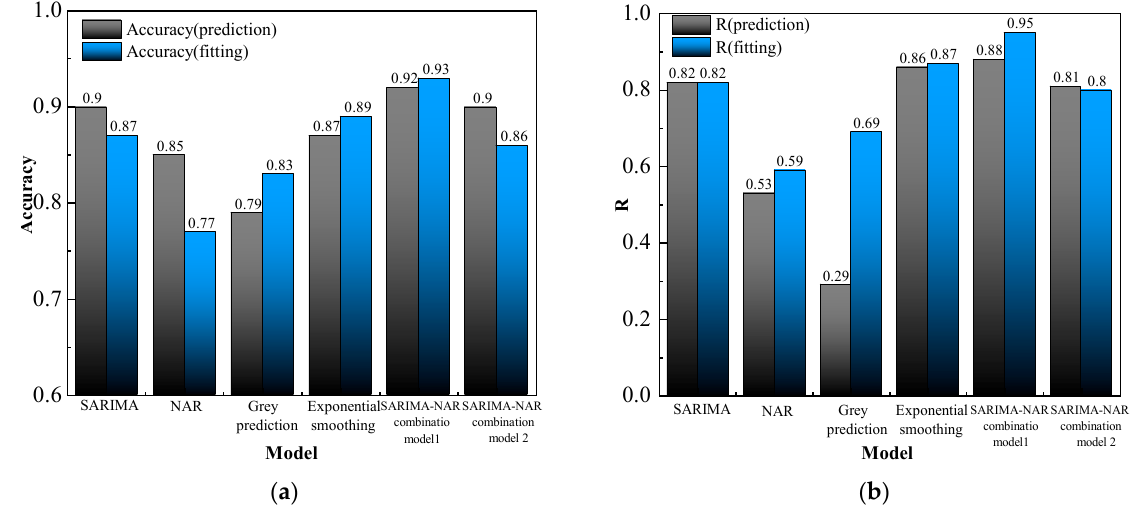
Figure 11. Accuracy index statistics of fitting and prediction. ( a ) Accuracy (A), ( b ) Correlation coefficient